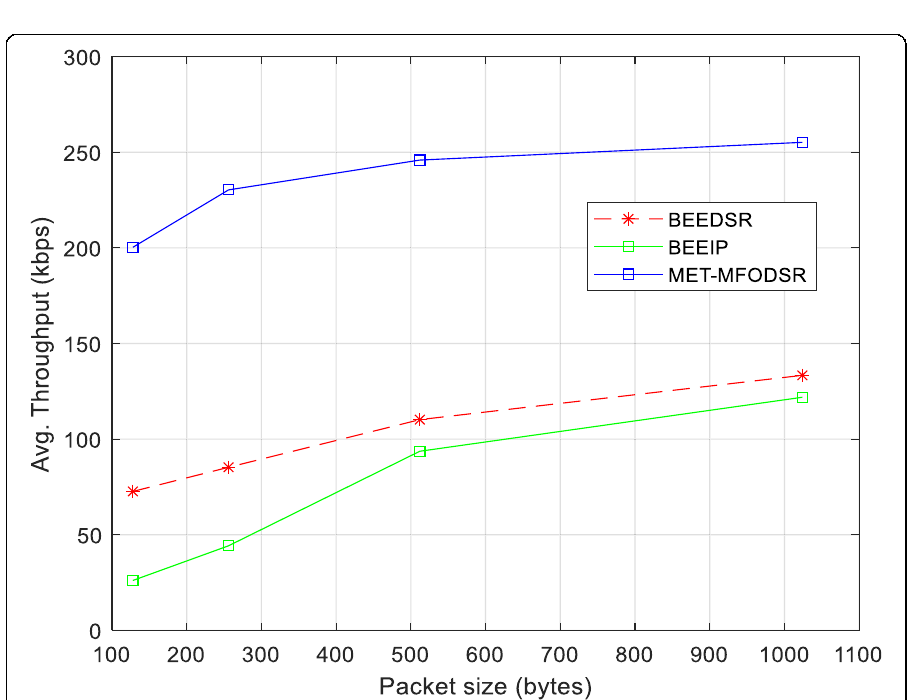
Fig. 4 Average throughput simulation results for BEEDSR, BeeIP, and MET-MFODSR. The simulation results of the average throughput under the packet size